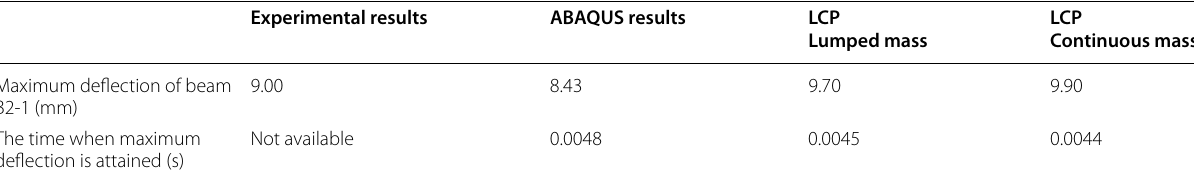
Table 4 Summary of results of maximum